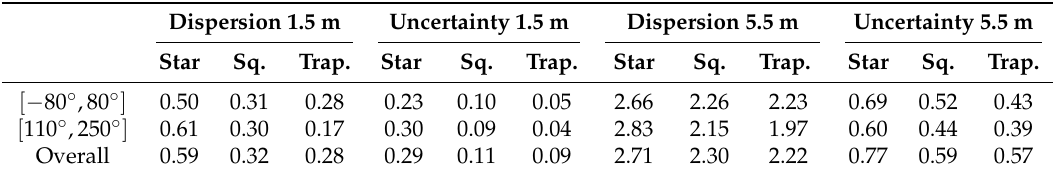
Table 1. Average performance in all directions and two broad circular sectors for the three configurations of antennas. All data are shown in meters.